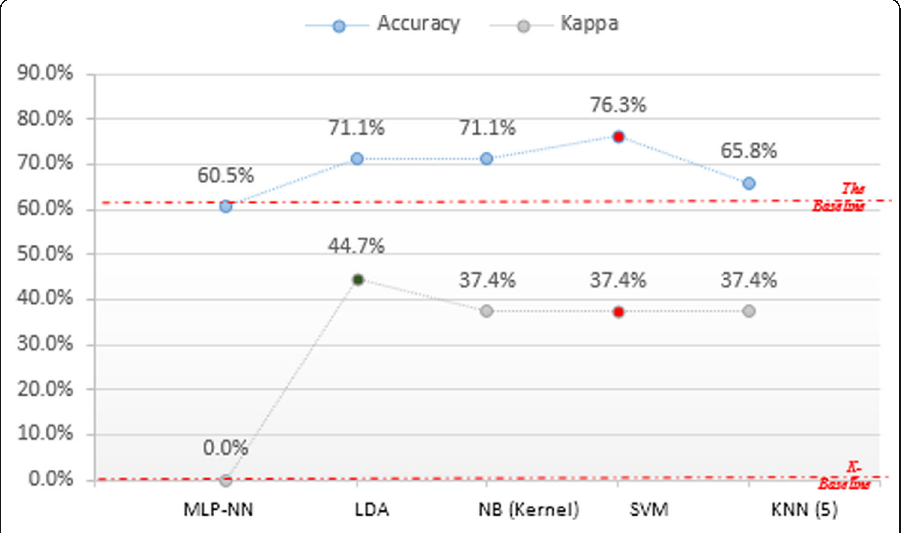
Fig. 7 Visualizing Dataset 2 using Traditional